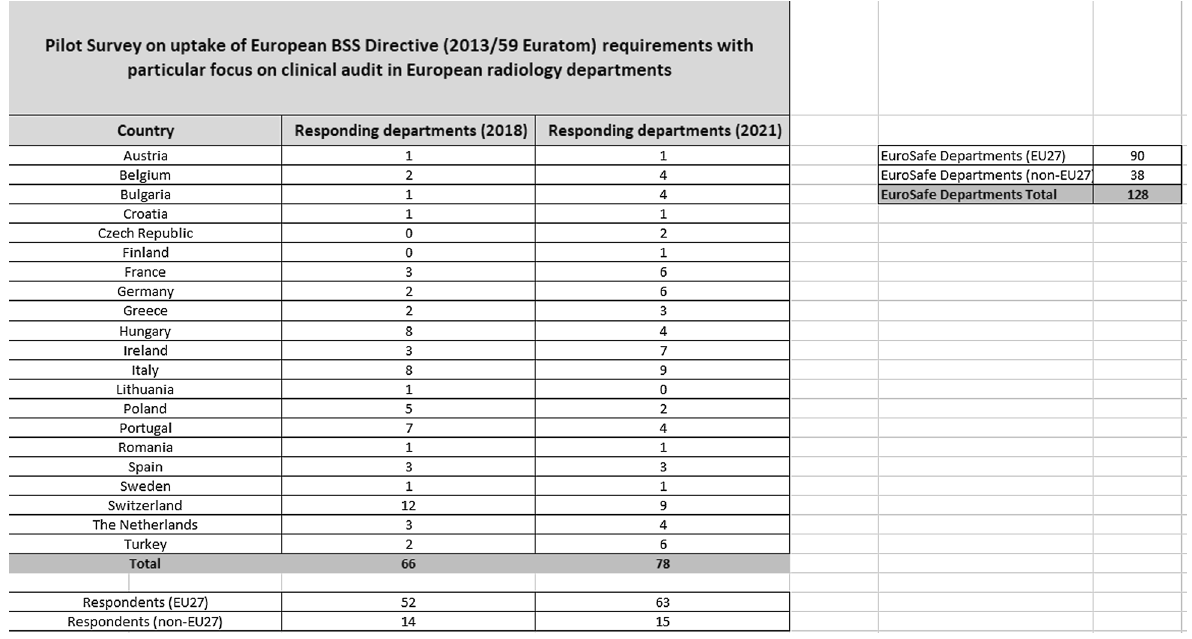
Table 1 Pilot Survey on uptake of European BSS Directive (2013/59 Euratom) requirements with particular focus on clinical audit in European radiology